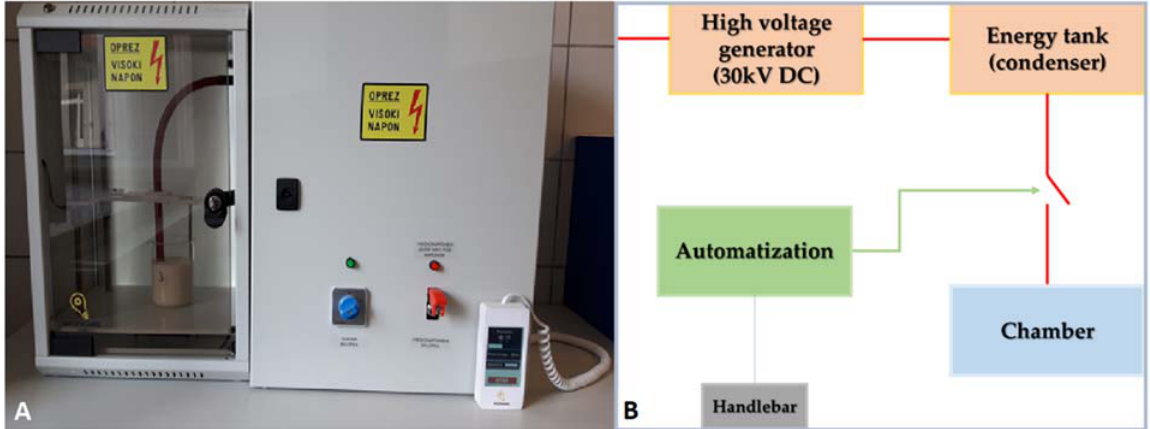
Figure 7. The high-voltage electrical discharge (HVED) device used in the study ( A ) and a basic HVED schematic diagram ( B ).